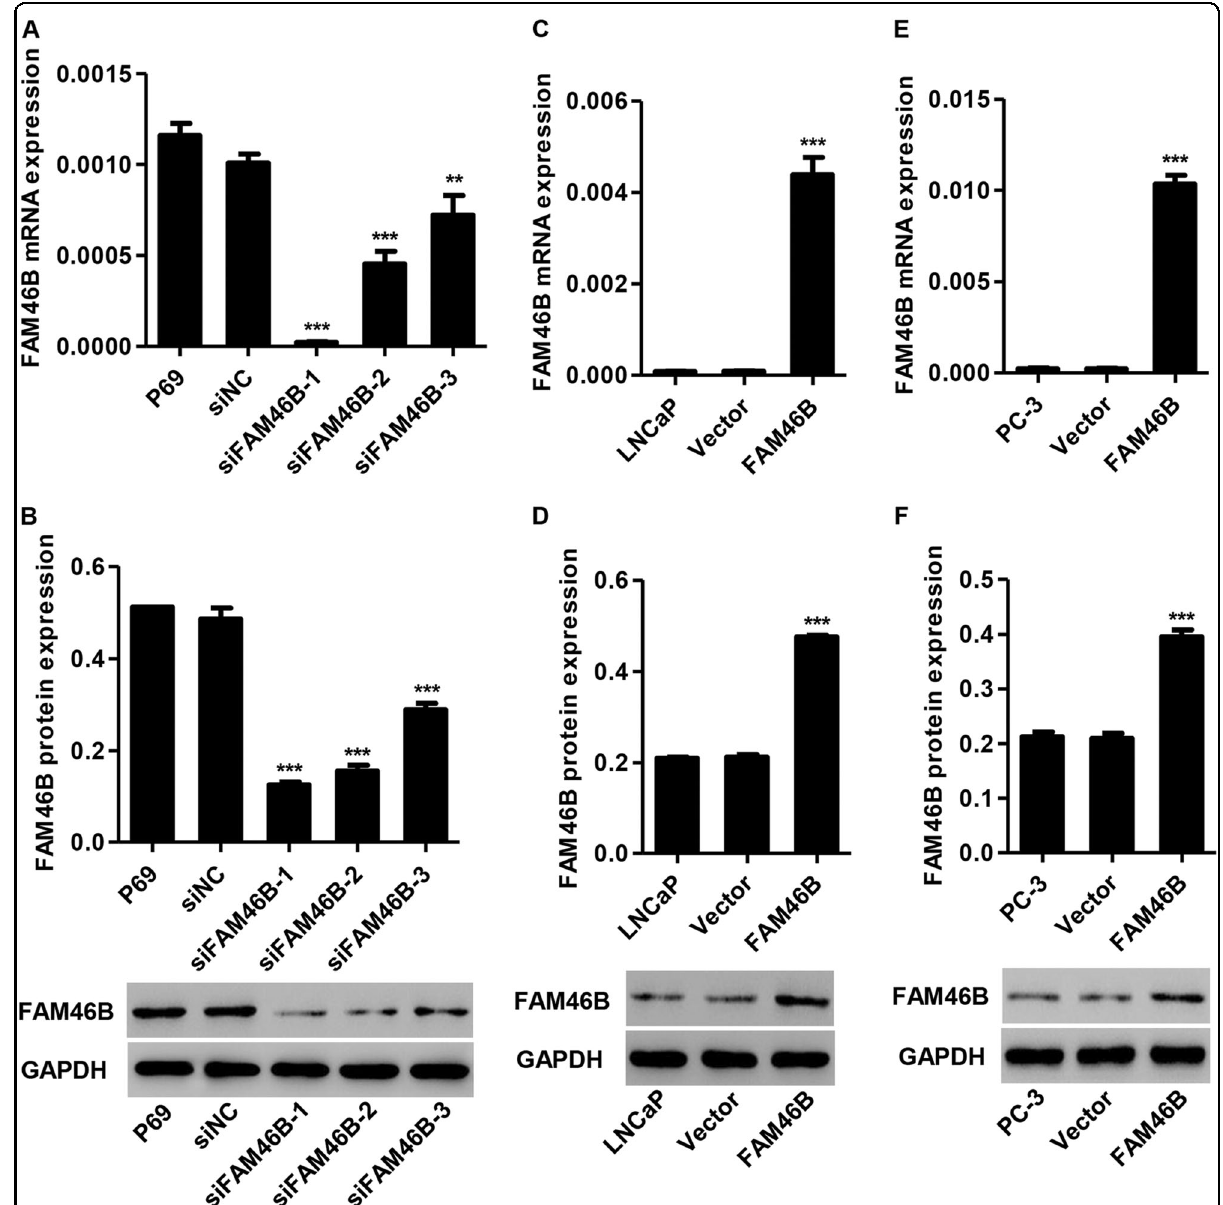
Fig. 2 Construction of FAM46B RNAi and overexpressing cell lines Real-time PCR and western blotting were performed to examine the mRNA and protein expression of FAM46B in P69 cells a , b transfected with siFAM46B-1, siFAM46B-2, or siFAM46B-3, and in LNCaP c , d and PC-3 cells e , f transfected with pLVX-Puro-FAM46B. ** P < 0.01, *** P < 0.001 compared with siNC or blank